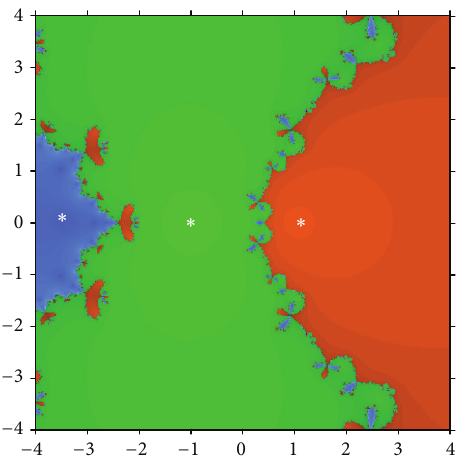
(𝑧) with three basins of L 4